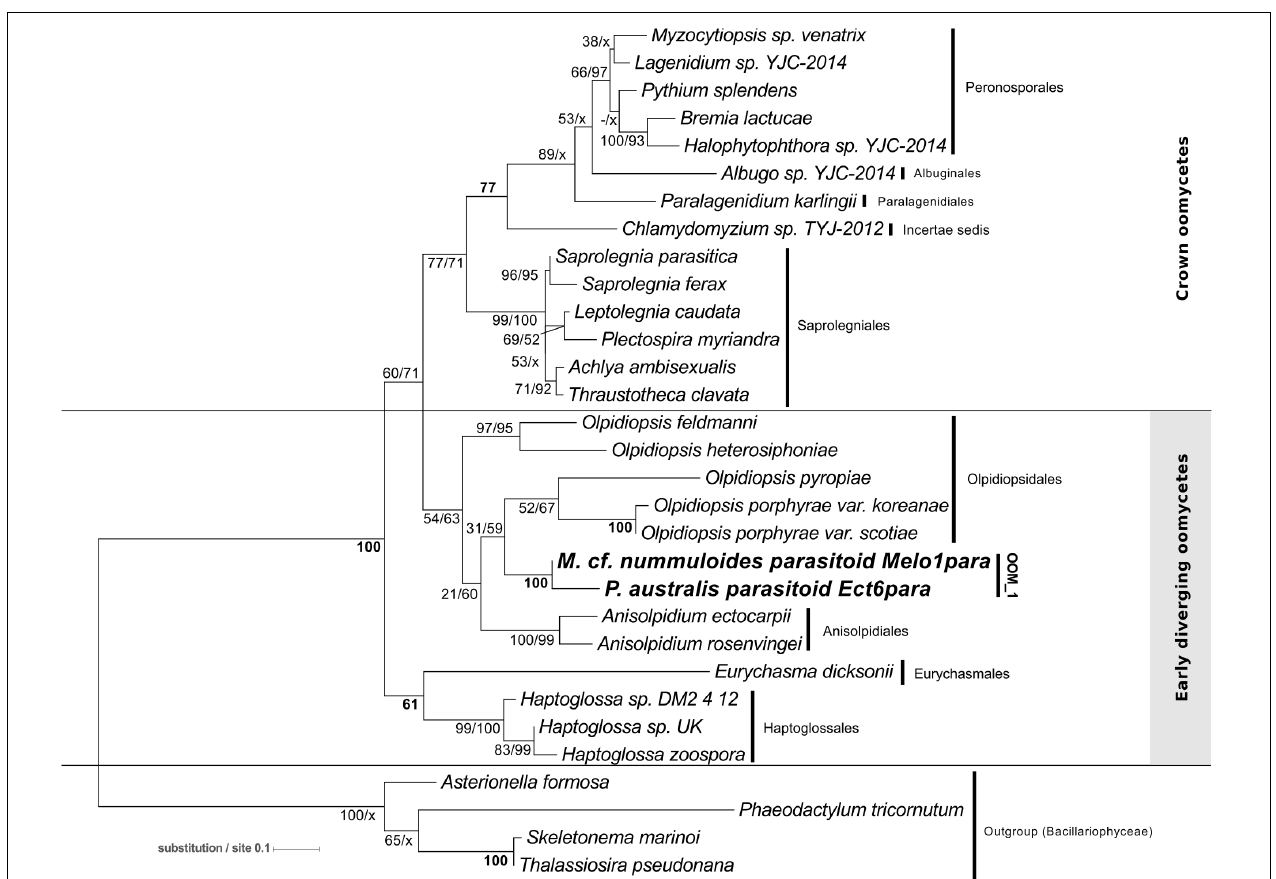
FIGURE 4 | Maximum-likelihood phylogenetic tree reconstruction using 31 concatenated amino acid sequences for the mitochondrial genetic markers cox1 (194 positions) and cox2 (185 positions) of the parasitoid of Melosira cf. nummuloides (in bold) within the oomycetes (Stramenopila). The cox2 amino acid sequence of the parasitoid of P. australis Ect6para (in bold) was also included. Four diatoms (Stramenopila, Bacillariophyceae) were defined as outgroup. Bootstrap values (1,000 replicates) are shown at each node for ML and NJ methods, respectively. Bold numbers indicate agreement on the same bootstrap value for both methods. Refer to the alignment in Supplementary Data Sheet S3